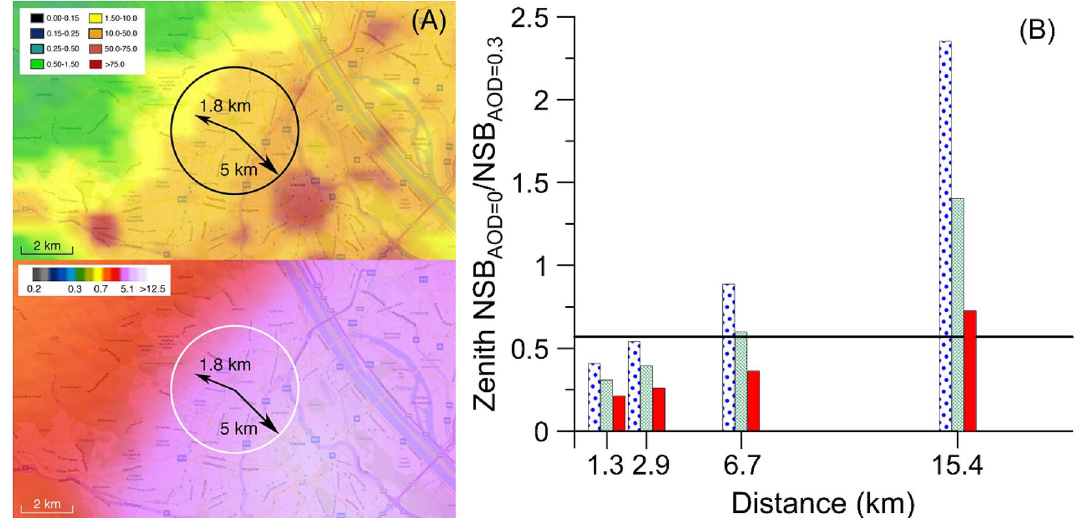
Figure 3. Sources of artificial light near the Vienna measuring station and their modeled NSB impact as a function of AOD and distance. ( A ) Situation of the University of Vienna Institute for Astrophysics (IFA) with respect to the spatial distribution of upward radiance and zenith night sky brightness over the city of Vienna, Austria. In the top panel, the upward-directed radiance in nW cm −2 sr −1 is shown in false colors according to the key at upper left, overlaid on a background map of Vienna. The zone defined by the 5-km circle encloses light sources with the highest relative importance for the experimentally determined ratio of NSB AOD = 0.06 /NSB AOD = 0.4 discussed in the main text. In the bottom panel, the same information is shown but the false colors indicate the predicted zenith night sky brightness from the maps of Falchi et al. 1 . The scale at upper left shows the zenith brightness in units of mcd m −2 . ( B ) Model predictions of the NSB AOD = 0.06 /NSB AOD = 0.4 ratio as a function of light source distance from the Vienna measurement station. The ratios computed are shown as bars with blue dots for wavelengths of 450 nm, bars with green crossed lines for 530 nm, and red bars for 650 nm. The horizontal black line indicates the measured NSB AOD = 0.06 /NSB AOD = 0.4 NSB ratio